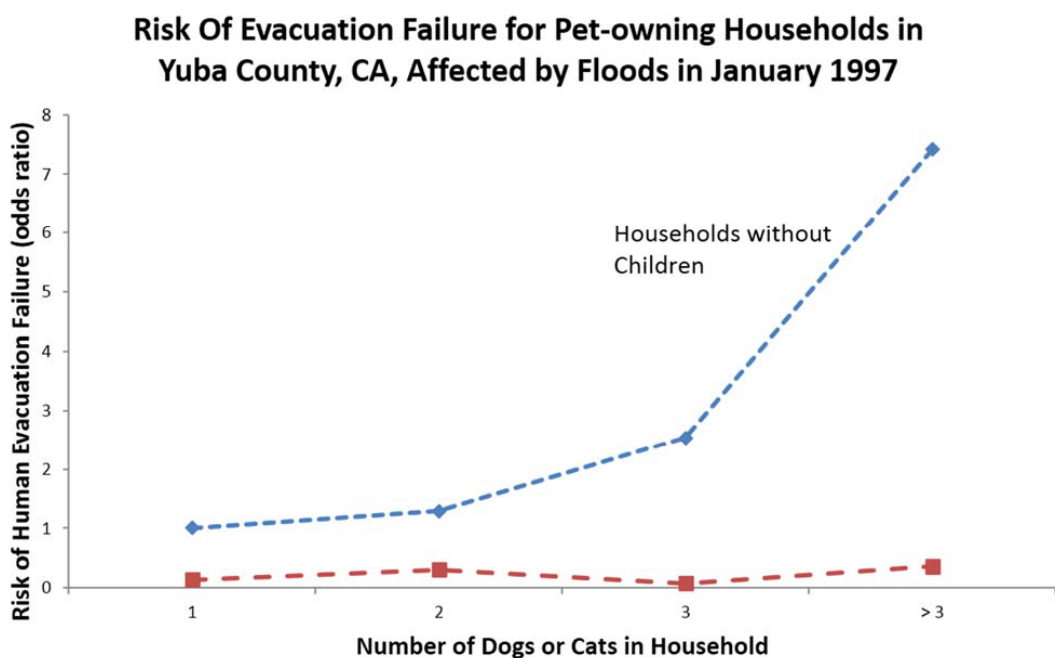
Figure 3. Chart correlating the likelihood of pet owners not evacuating with the number of pets owned and whether the household has children [21].